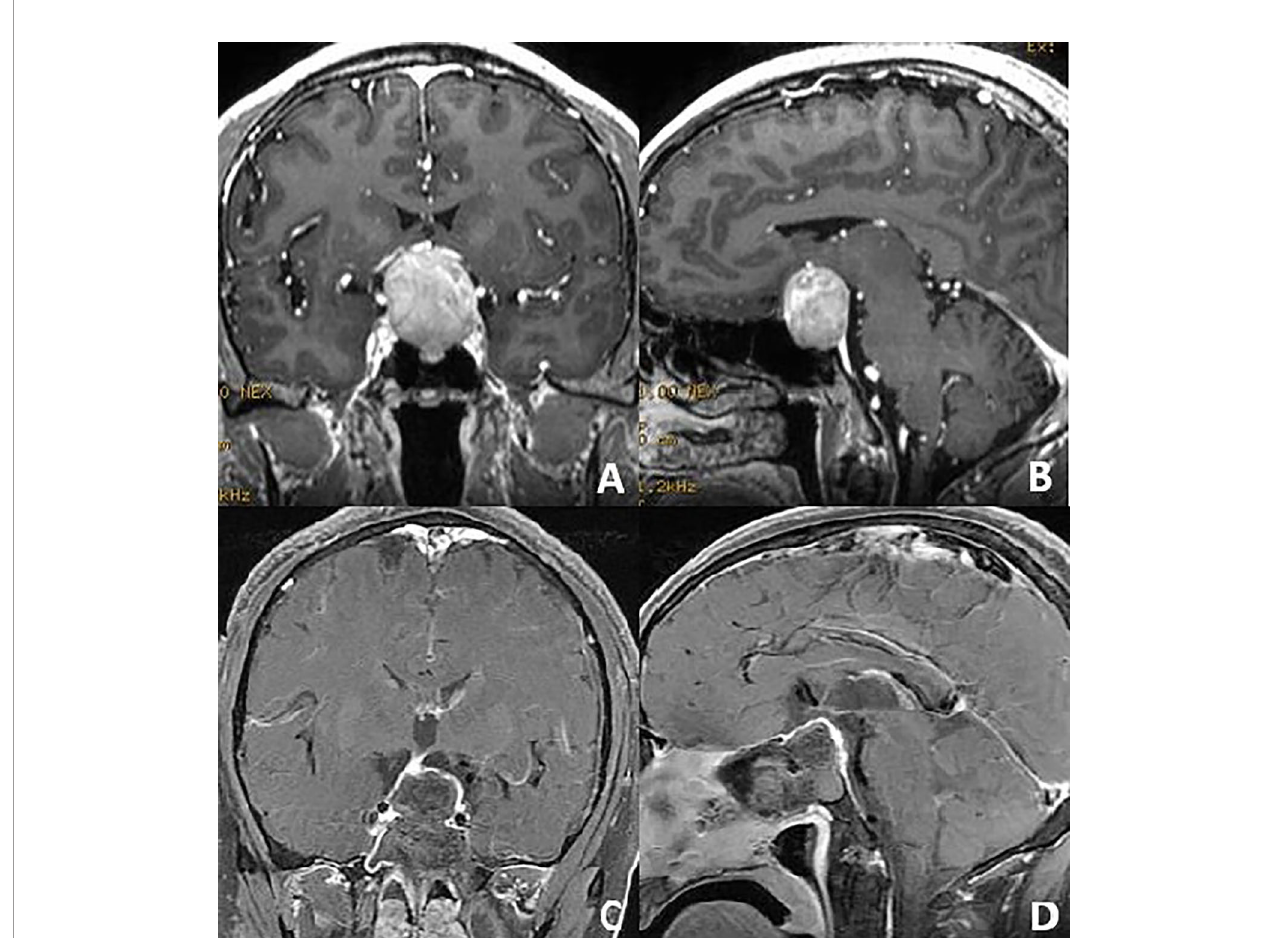
FIGURE 1 | Preoperative coronal and sagittal (A, B) contrast-enhanced magnetic resonance T1-weighted images of a non-functional pituitary macroadenoma. After the endoscopic anterior and posterior pseudocapsule dissection, the adenoma was achieved total resection (C, D)